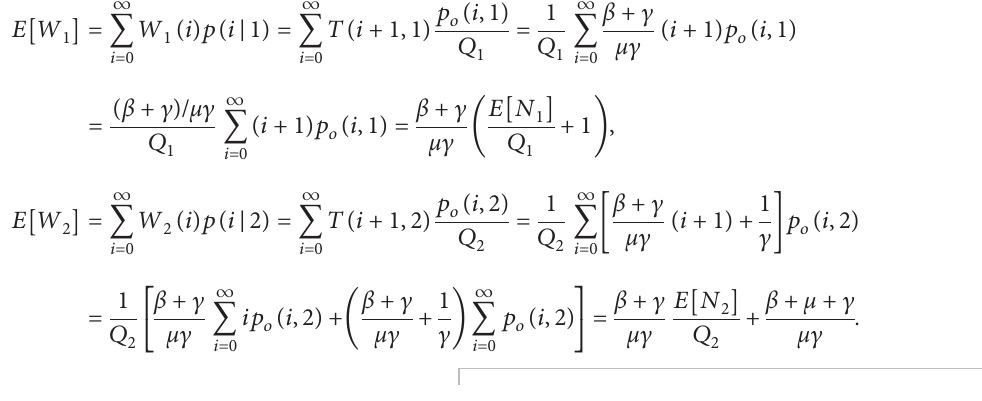
( λ ∗ , λ ∗ , λ ∗ ) vs. α and N o 0 1 2